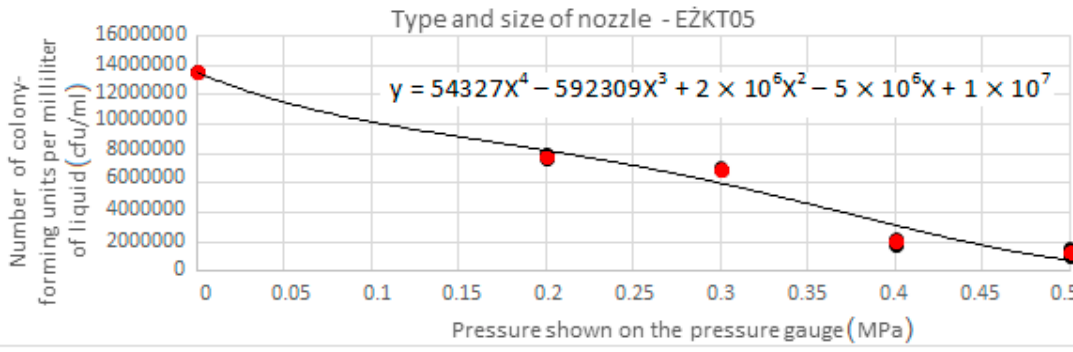
Figure 12. The influence of pressure on survival of cfu/mL of liquid for E Ż KT05.